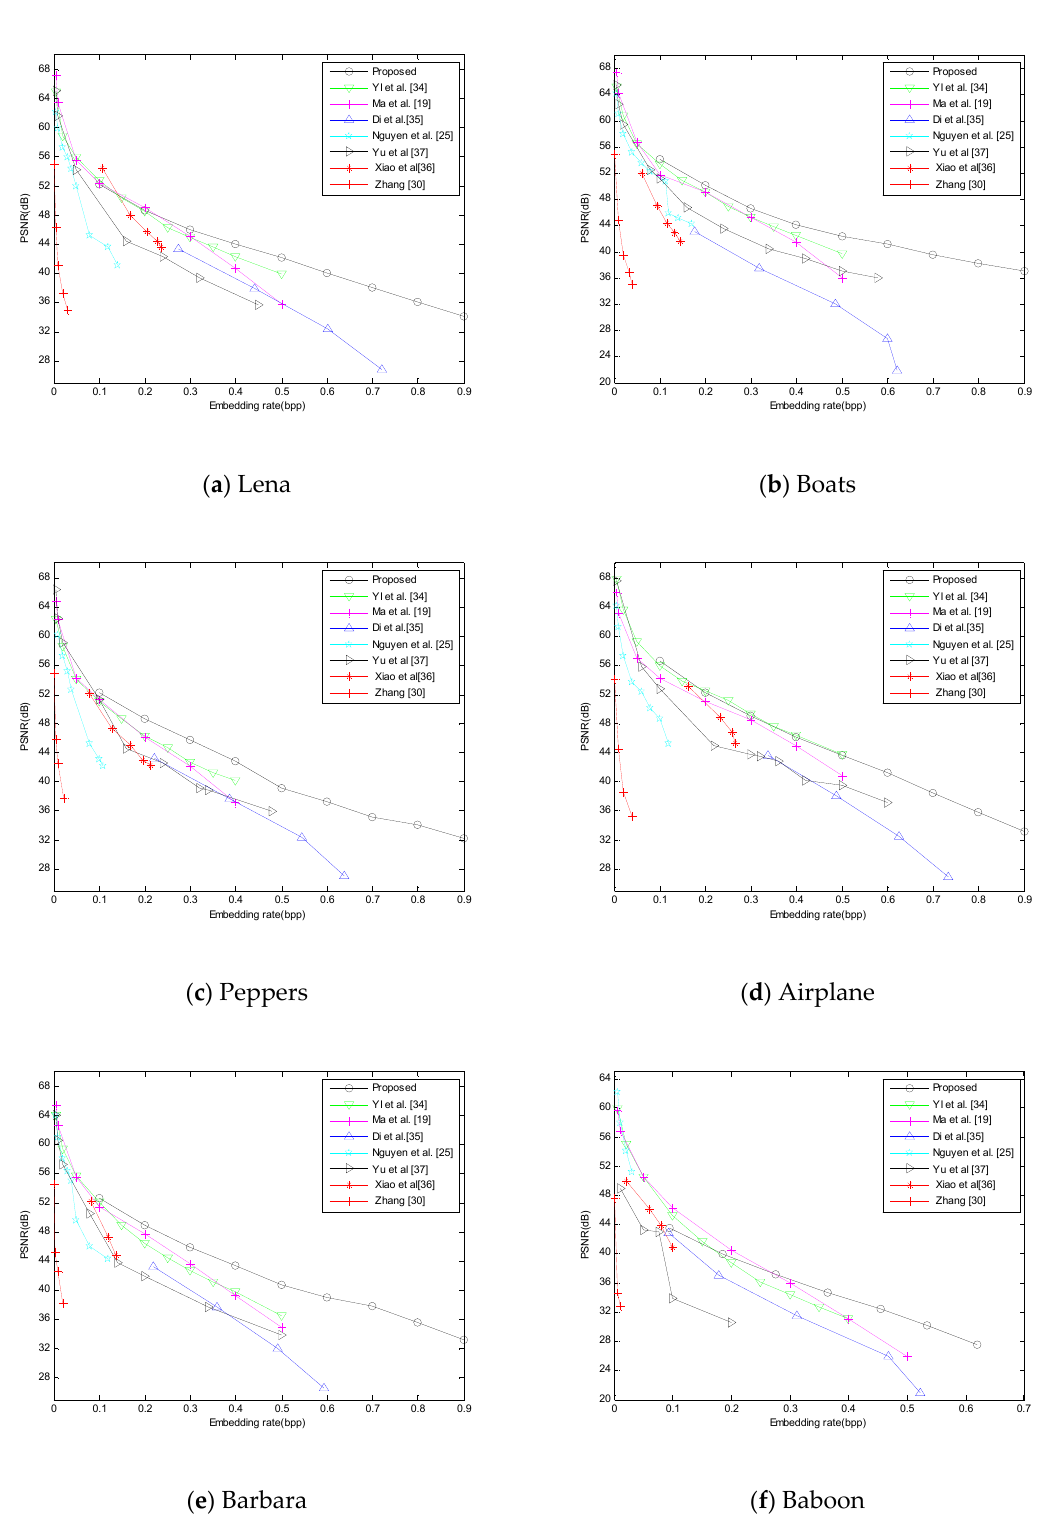
Figure 10. PSNR comparison among different methods.